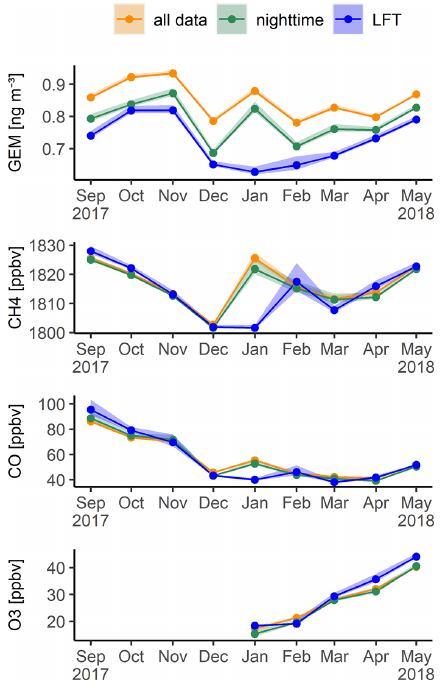
Figure 3. Estimated concentrations of atmospheric GEM, CH 4 , CO, and O 3 in the lower free troposphere (LFT) of the SH tropical Indian Ocean, as inferred from dry nighttime air masses arriving at Maïdo. LFT time series (blue lines) were obtained by selecting only nighttime data (23:00–05:59LT, green lines) from all observations (orange lines), followed by the application of a specific humidity filter. The shaded area encloses the mean ± 2 times the standard error.